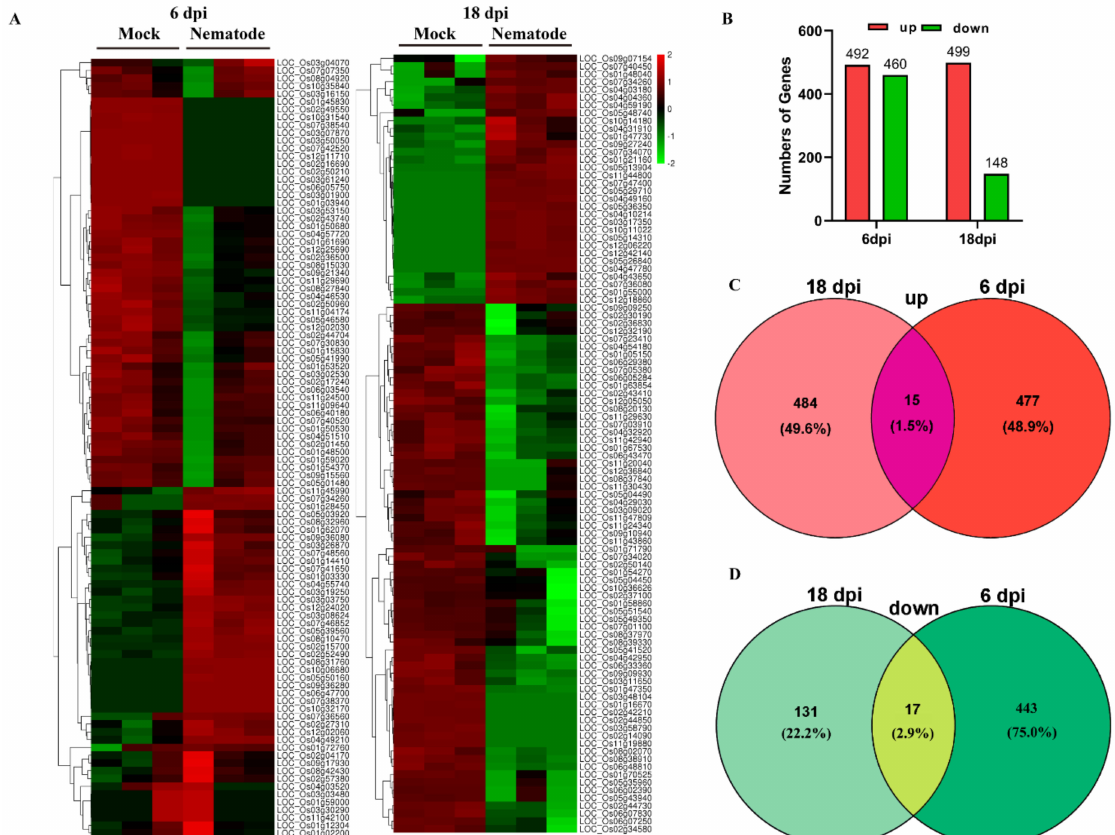
Figure 2. Di ff erentially expressed genes (DEGs) induced by root-knot nematodes at 6 and 18 dpi. ( A ) Cluster heat map showing the level of expression of di ff erential genes; ( B ) Up- and downregulated genes; ( C ) Venn diagrams showing intersection of genes that were upregulated at either 6 or 18 dpi; ( D ) Venn diagrams showing intersection of genes that were downregulated at either 6 or 18